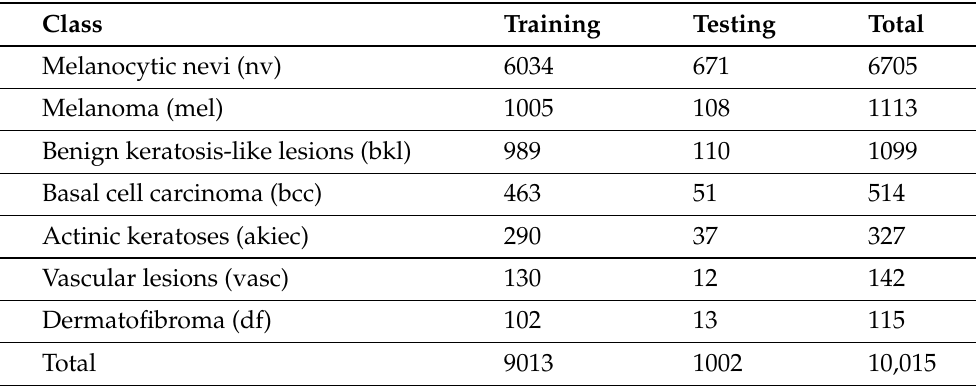
Table 3. Statistics of skin disease classification